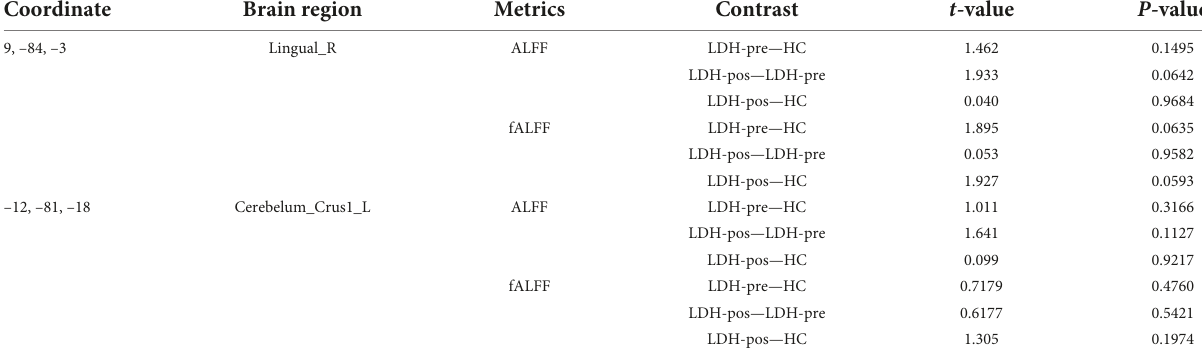
TABLE 5 Group differences in ALFF and fALFF in slow-5 band.